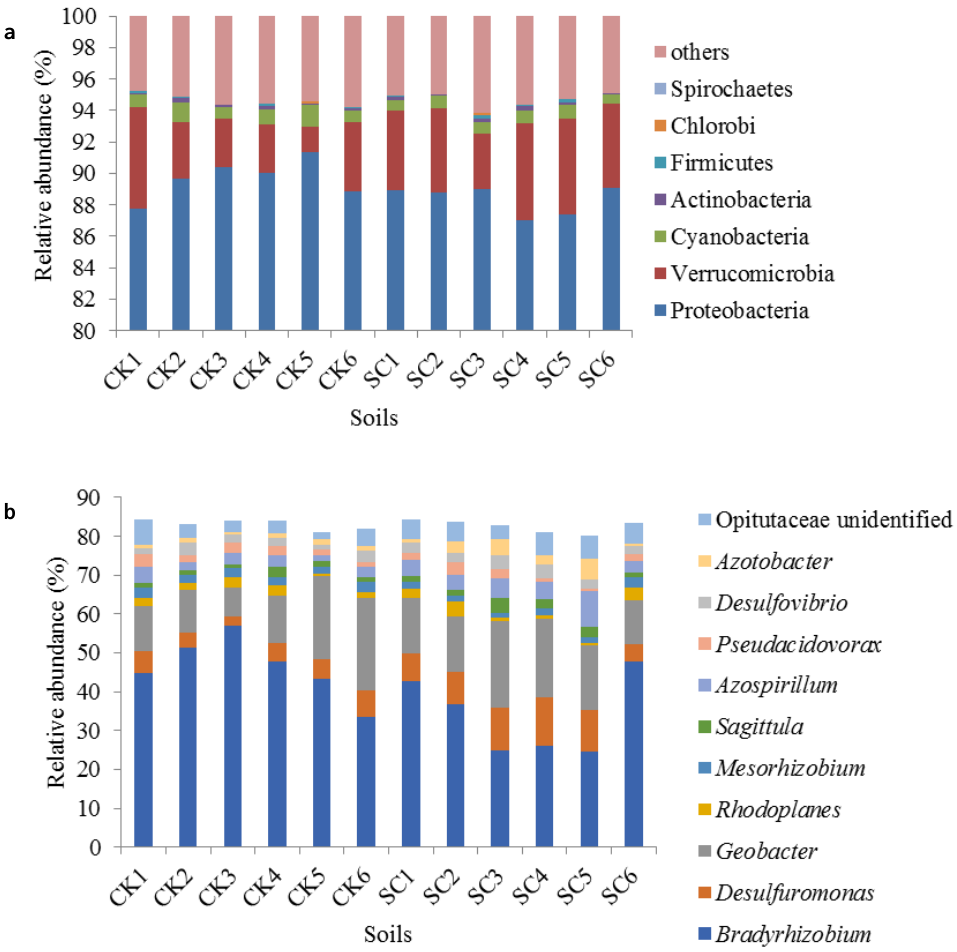
Figure 1. Relative abundances of taxonomic groups in SC and CK. Abbreviations: SC, grasslands invaded by S. chamaejasme ; CK, uninvaded grasslands. ( a ): relative abundances of phyla; ( b ): relative abundances of genera.